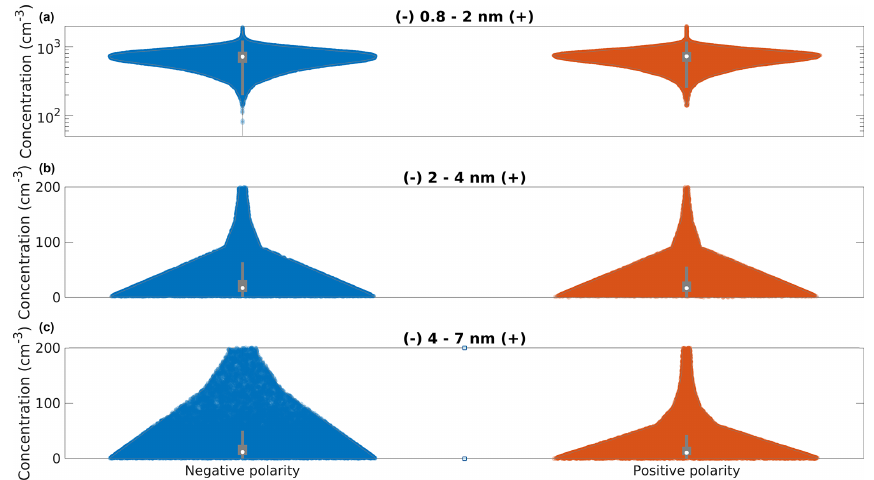
Figure 3. Measured ion concentrations. Negative polarity is on the left in blue, and positive polarity is on the right in orange. The cluster ion (0.8–2nm) concentrations are in (a) , and intermediate ion concentrations are in (b) and (c) , 2–4 and 4–7nm, respectively. The white dot is the median concentration, and the whiskers mark the location of the 95th and 5th percentile data points. Table 2. Descriptive statistics of the ion measurements dataset between 2005 and 2021.